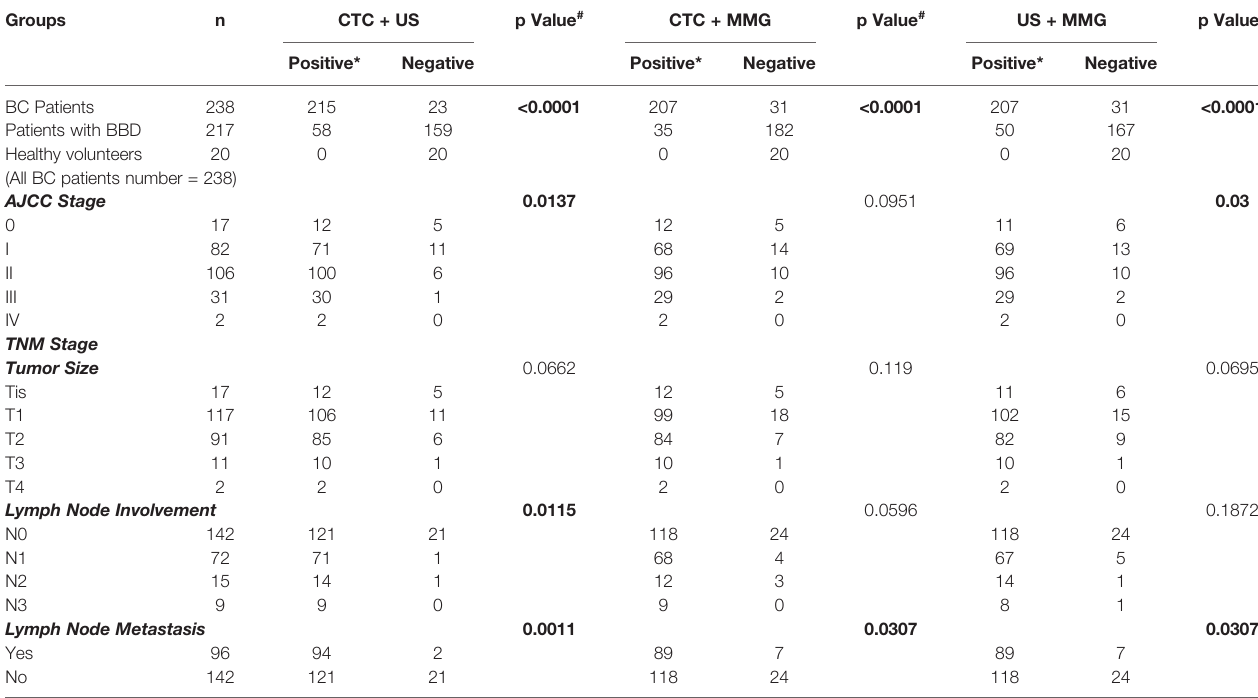
TABLE 4 | Clinicopathological characteristics of BC patients diagnosed by CTC combined with US, CTC combined with MMG, or US combined with MMG.